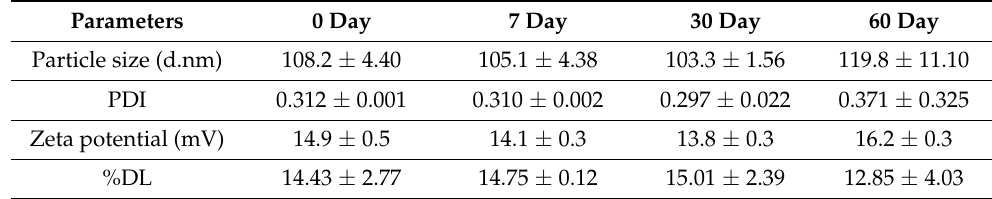
Table 5. Stability data of lyophilized RTG-LCNP powder.